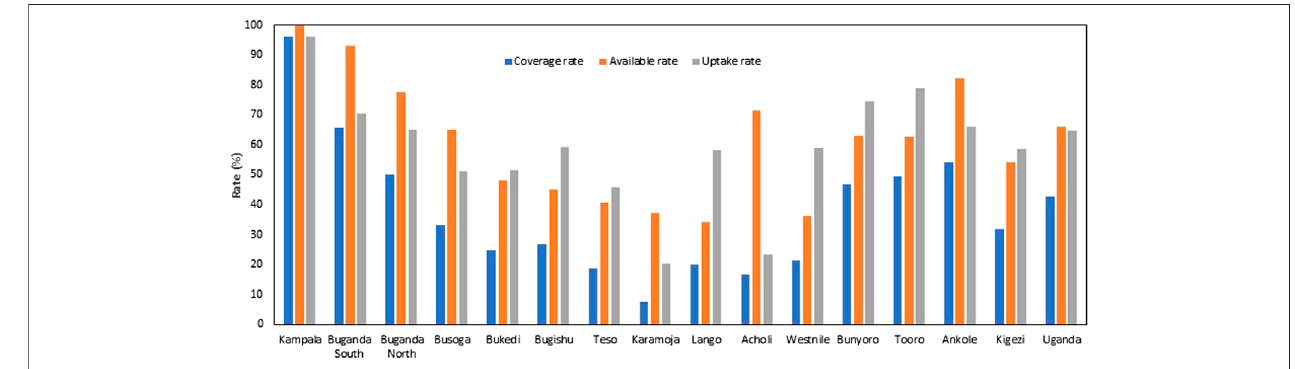
FIGURE 2 | Electricity Coverage, availability, uptake, and Un-served households by sub region.